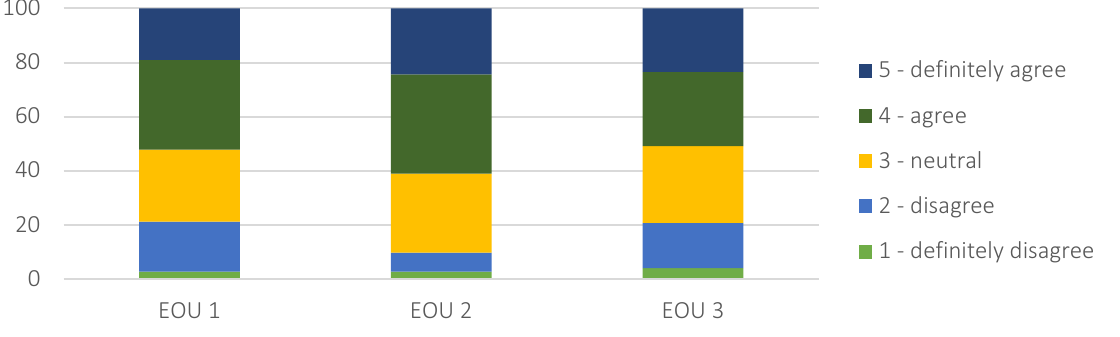
Figure 4. Perceived simplicity